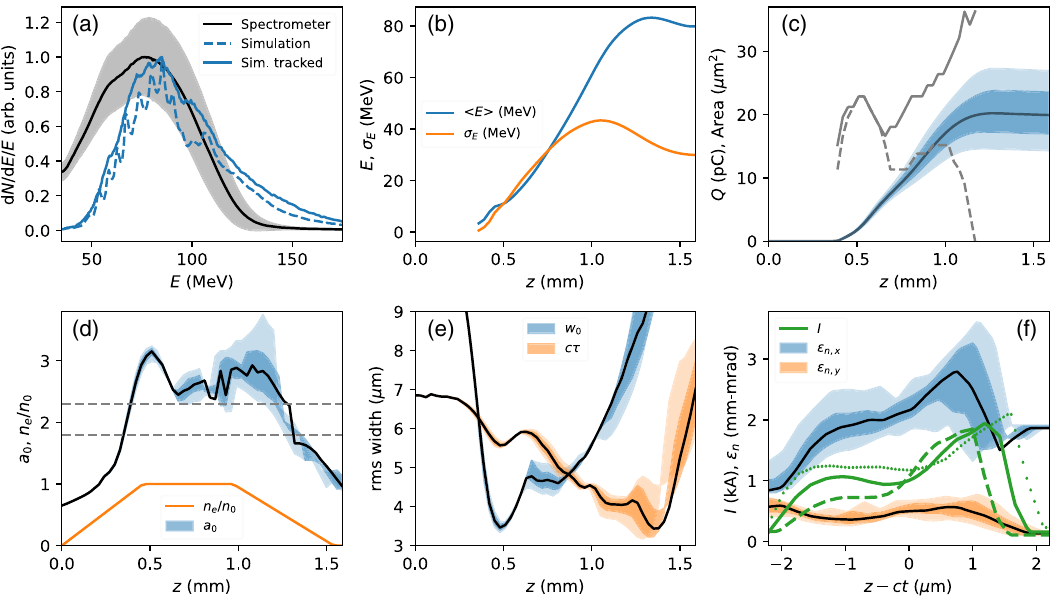
FIG. 6. PIC simulation results. (a) Normalized experimental electron spectrum (black) with its standard deviation (grey), the raw simulated spectrum (blue dashes), and the simulated spectrum propagated to the spectrometer screen (solid blue line). (b) Simulated mean energy (solid blue) and rms energy spread (orange) vs z . (c) Simulated charge from II vs z at n e (cid:2) ð 1 ; 2 Þ σ n (bounded by the blue e and pale blue shaded areas). The behavior at n e is shown in black, as it is in all following plots. The peak area of the laser pulse envelope with sufficient intensity to produce N 6 þ is shown for the lowest (dashed line) and highest (solid line) density simulations in grey, in the region where charge is trapped. (d) Simulated a 0 evolution at densities n e (cid:2) ð 1 ; 2 Þ σ n . Normalized n e ð z Þ is shown in orange. The grey e dashed lines are the a 0 thresholds required to ionize the core electrons of nitrogen according to the ADK model [61]. (e) Laser waist w 0 (blue) and length c τ (orange) vs z at n e (cid:2) ð 1 ; 2 Þ σ n . (f) Normalized slice emittance in x (blue) and y (orange) of II electrons at e n (cid:2) ð 1 ; 2 Þ σ z ¼ 1 mm. In dashed, solid, and dotted green are the corresponding current profiles at n − 2 σ n n þ 2 σ e n e at e n e , e , and e n e . In higher n e simulations the w 0 and c τ are smaller, while a 0 , Q and ϵ n are